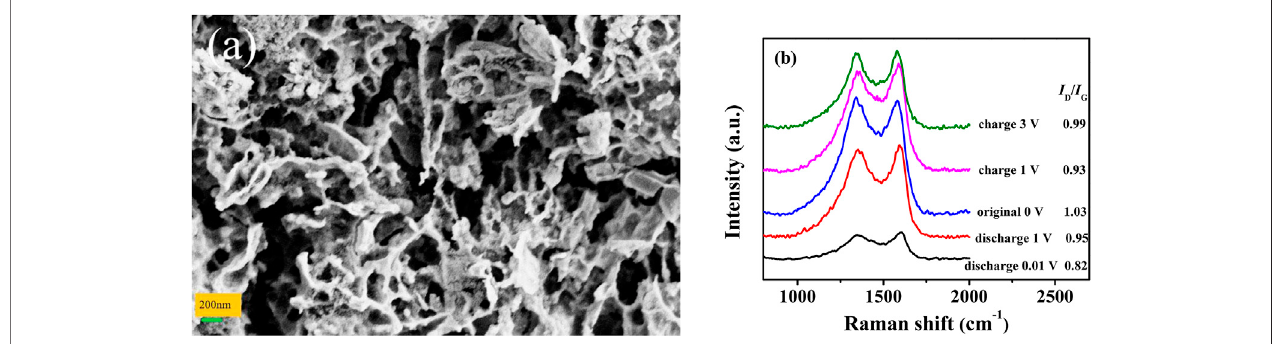
FIGURE5| Effectofcyclingontheanodemicrostructure.SEMimagesof (A) BZPCafter1,000cyclesbeforetesting. (B) Ex-situ RamanspectraofBZPCatvarious states.